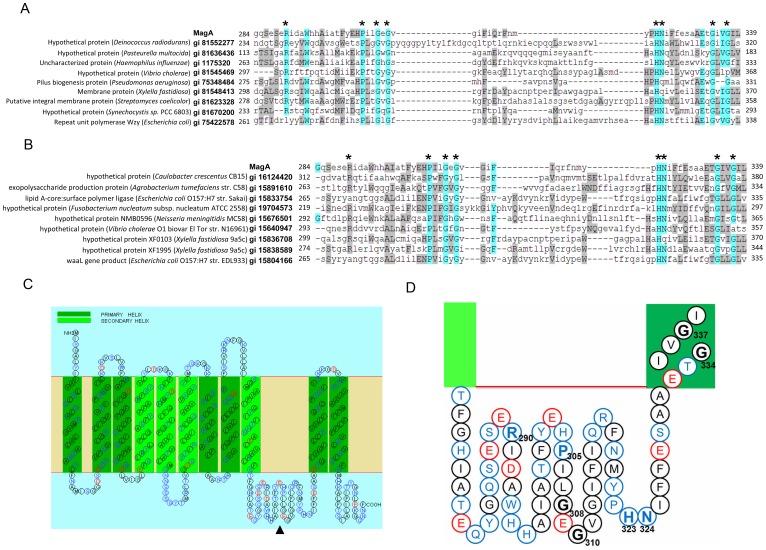
Conserved amino acids and the predicted transmembrane topology of MagA.Use MagA sequence to query NCBI Conserved Domain Database found two types of protein domains sharing the similarities with the amino-acid residues 284–339 of MagA. Eight conserved amino acids are found in both protein domain alignments. Topology prediction shows that most conserved amino acids are located in an inter-transmembrane region. A., B. The sequence alignments of MagA and nine sequences with Wzy_C domain, and nine sequences with RfaL, respectively. The sequences were aligned by the MUSCLE web tool (http://www.bioinformatics.nl/tools/muscle.html) using default parameters. Amino acids are colored in Belvu program by average similarity according to BLOSUM62 substitution matrix score from most similar (light blue) to less similar (gray). The residues showing high conservation in both profiles are marked with stars. C. The predicted topology of MagA made by SOSUI. The hypothetical loop (residue number 274 to 331) is indicated by the arrow head. D. The locations of eight conserved amino acids (a zoom of Figure 1C). Conserved amino acids are labeled by bold residue numbers. Six of eight conserved amino acids are on the loop. The other two are in the adjacent transmembrane area.